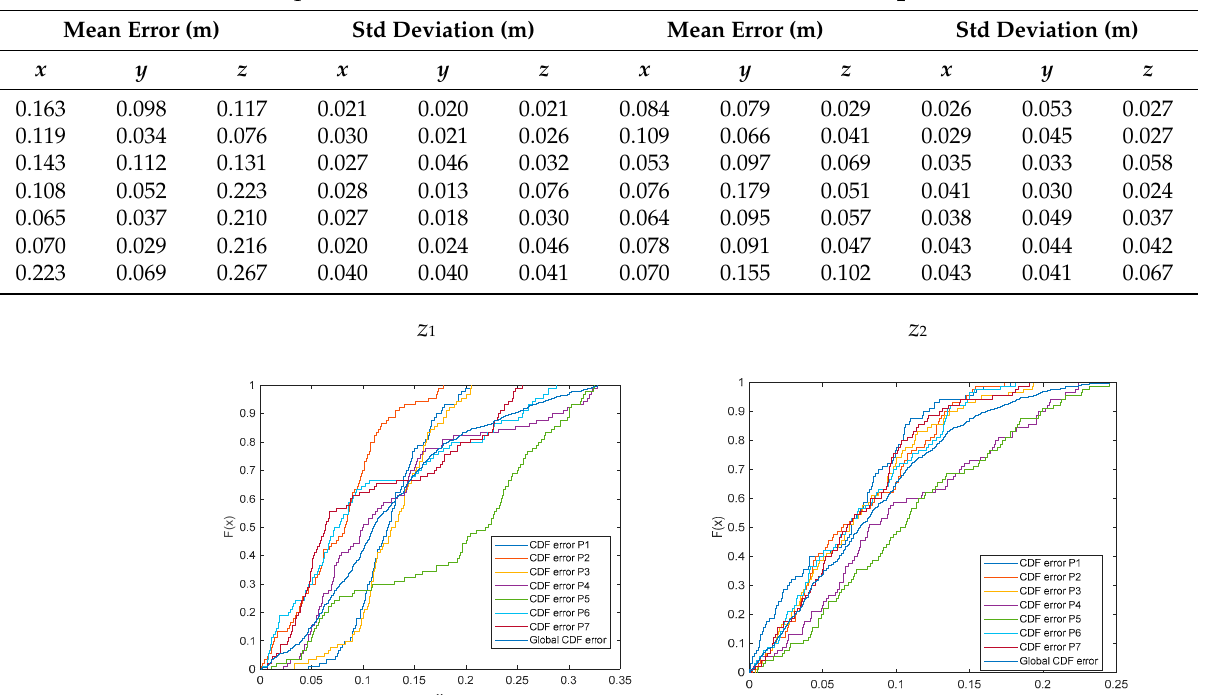
Figure 11. Positioning errors (CDF), for an EKF and three ULPS ( σ w = 0.2 m), for the three coordinates, x , y and z , for the grid of positions (P1–P7), at z 1 = 1.35 m ( left ) and z 2 = 1.93 m ( right ).